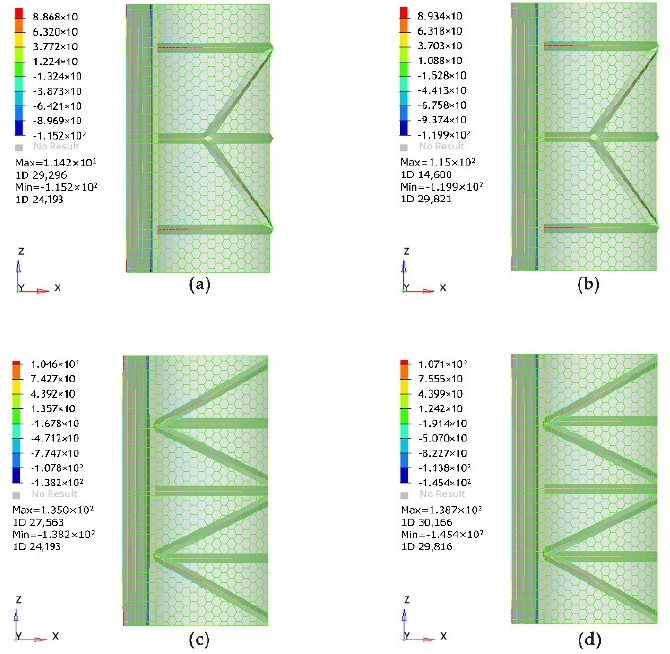
Figure 19. ( a ) Linear stress analysis of the carport I model under the load of 1.2 G k + 1.4 × 0.85 Q S + 1.4 Q W ; ( b ) Nonlinear stress analysis of the carport I model under the load of 1.2 G k + 1.4 × 0.85 Q S + 1.4 Q W ; ( c ) Linear stress analysis of the carport II model under the load of 1.2 G k + 1.4 × 0.85 Q S + 1.4 Q W ; ( d ) Nonlinear stress analysis of the carport II model under the load of 1.2 G k + 1.4 × 0.85 Q S + 1.4 Q W under carport II model nonlinear stress analysis.